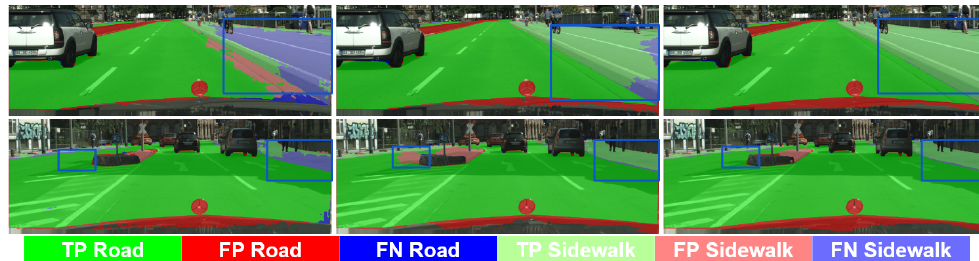
Figure 3. Qualitative results (GTAV + Synscapes → Cityscapes) focusing on TP/FP/FN for road and sidewalk classes. Columns, ( left ) to ( right ): SrcLAB, self-training stage, co-training loop (full co-training procedure). Blue boxes highlight areas of interest.